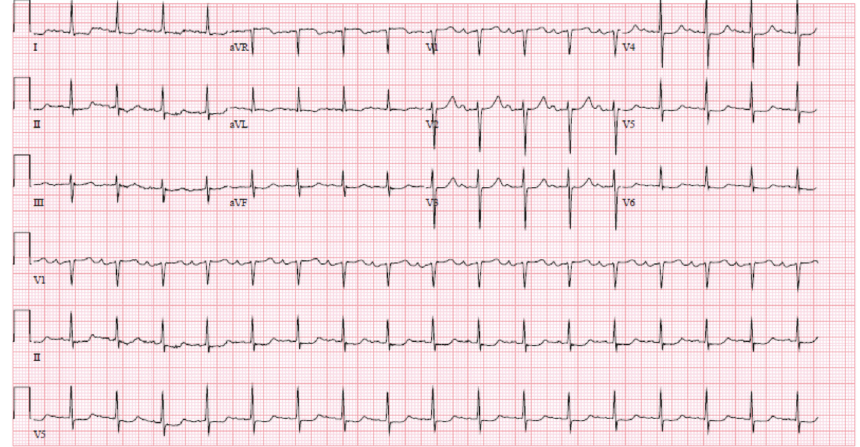
Figure 1: Electrocardiogram (ECG) showing sinus tachycardia with first degree atria-ventricular block, as well as ST and T wave abnormality suggestive of lateral ischemia.